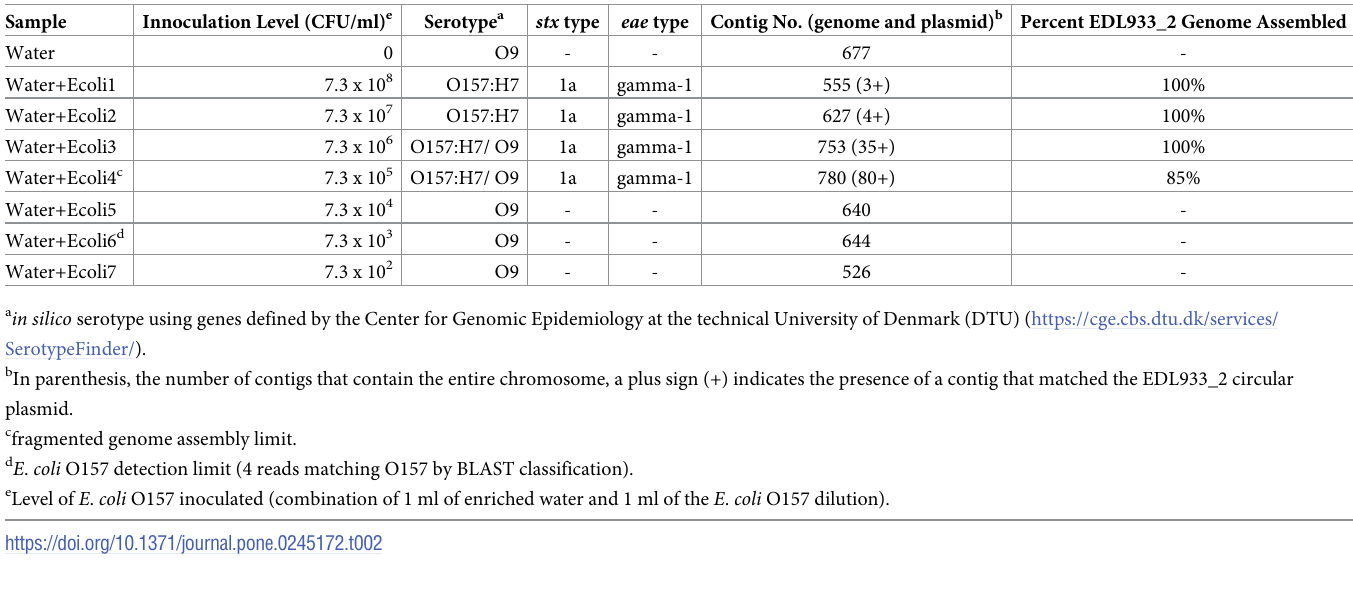
Table 2. Virulence genes assessment of the Flye assemblies obtained with all reads. Sample Innoculation Level (CFU/ml) e